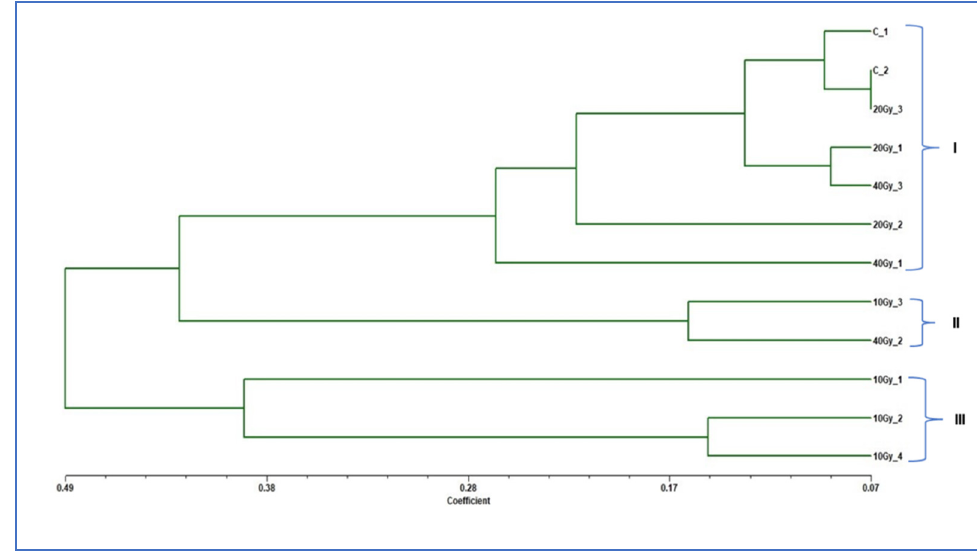
Figure 7. Dendrogram based on random amplified polymorphic DNA (RAPD) binary data. Dendro-